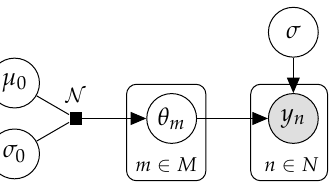
Figure 1. Graphical representation of parameters in Bayesian model for functional representation of the signal. Spline weights θ m come from the normal distribution with hyper-parameters µ 0 and σ 0 . Those parameters are inferred in the hierarchical way from data with uniform hyper-priors. Measurements y n are disturbed by a zero mean Gaussian noise with standard deviation of σ